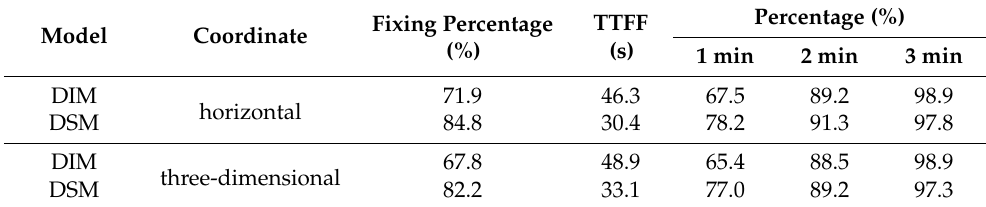
Figure 8. Time series of SD ionospheric residuals of DIM and DSM in large-scale networks. Dif- ferent colors represent SD ionospheric residuals of different satellite pairs.